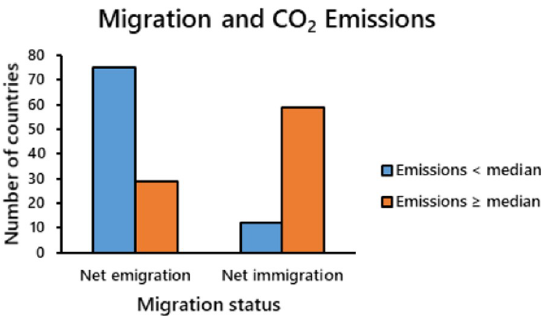
Fig 2. Frequency of countries with below and above median per capita CO 2 emissions in 2014 that were classified with either net human emigration or net immigration during the 5-yr interval between 2012 and 2017 ( N = 175; data from https://ourworldindata.org; downloaded 15 December 2019).